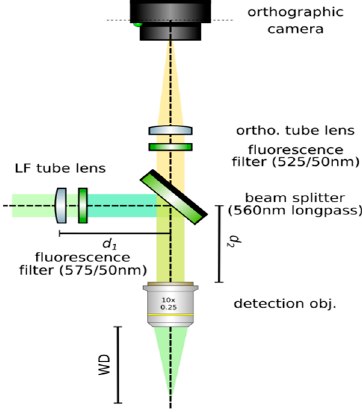
Figure 10. Place a detection objective.